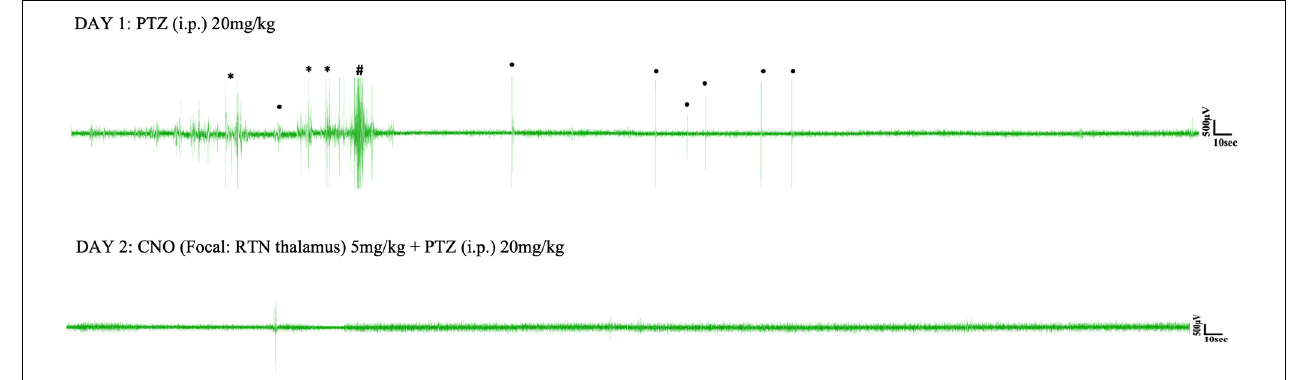
FIGURE 6 | Representative EEG traces from a PV Cre /Gq-DREADD animal after i.p. PTZ injection on day 1 and focal (RTN thalamus) CNO and i.p. PTZ injection on day 2. Asterisks ( ∗ ), hash signs (#), and dot signs ( • ) represent absence-like, tonic-clonic and other types of seizures, respectively. Each trace represents 10 min of EEG recording.